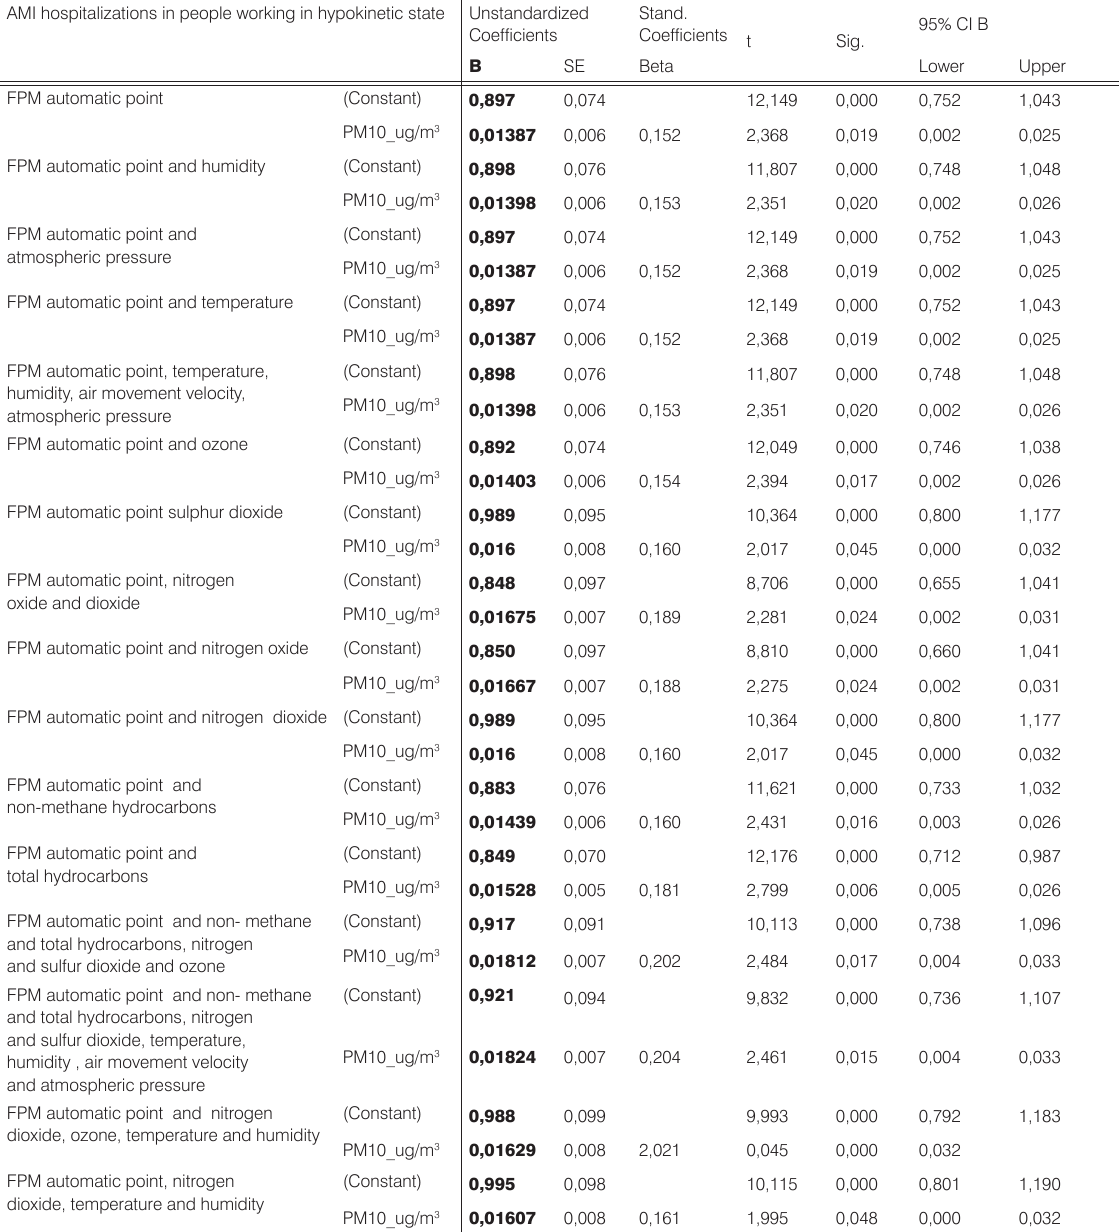
Table 4. Regression coefficients of the linear correlation between the frequency of AMI hospitalizations in people, working in hypokinetic state, and FPM concentrations at the point of “Ian Palach St.” (mean 24-hours values) in different models of combined action. AMI hospitalizations in people working in hypokinetic state Unstandardized Stand. Coefficients Coefficients